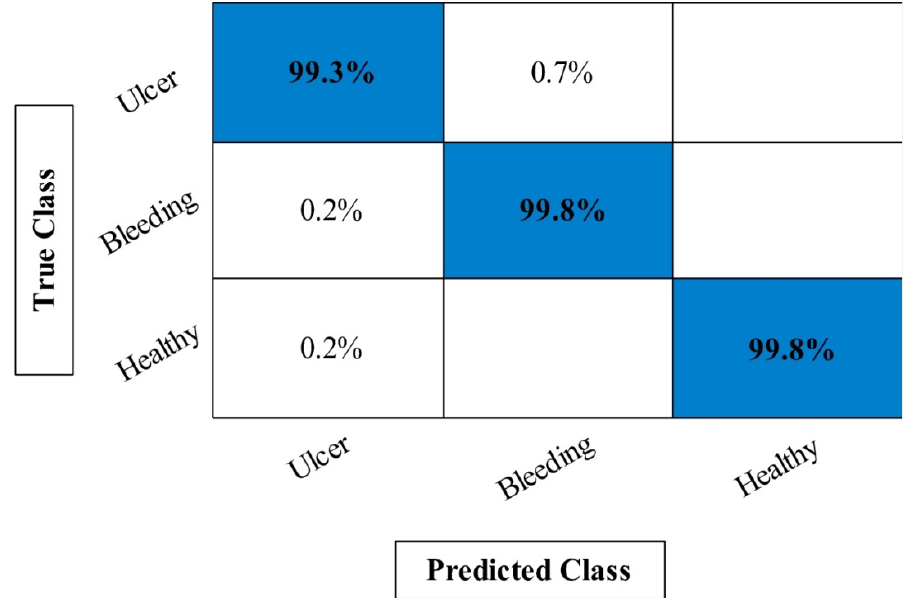
Figure 8. Confusion matrix of proposed framework for ELM classifier on CUI WCE dataset.